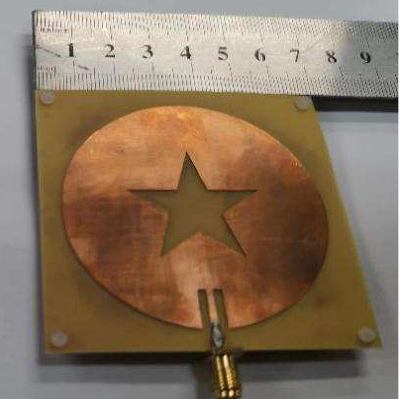
Figure 10. The fabricated Sensor.